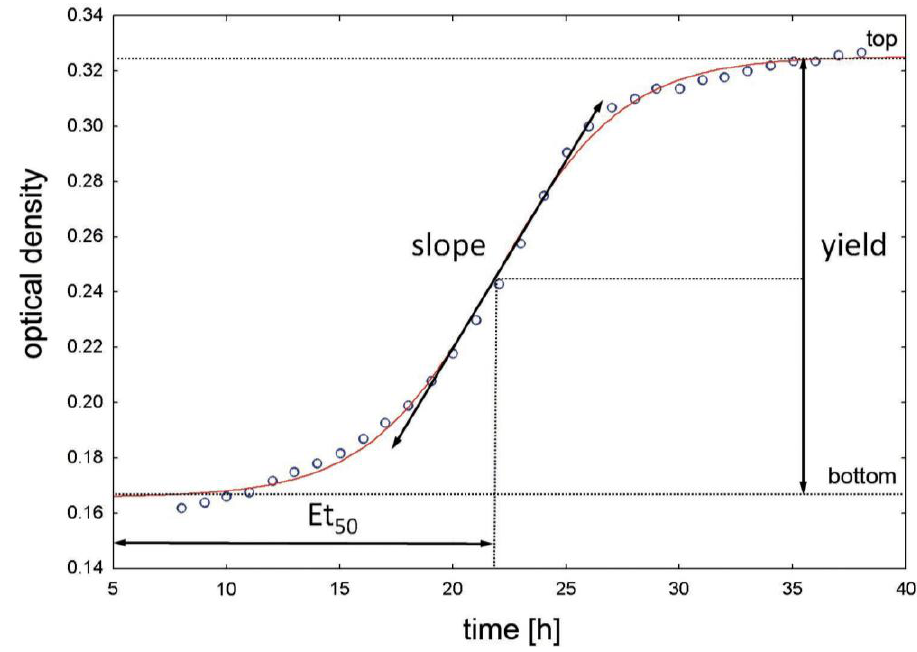
FIGURE 3. Parametrization of the S. cerevisiae growth curve. A four-parameter regression (top, bottom, slope, Et ) was fitted to the measured yeast growth data (empty 50 circles) for each well of the